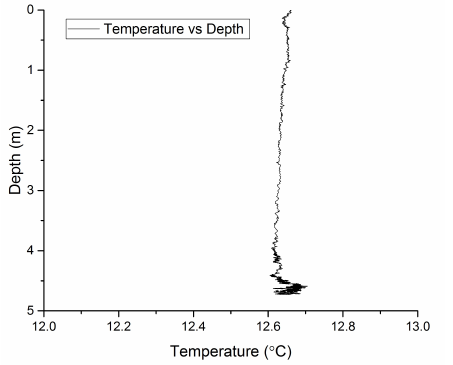
Figure 9. Depth and temperature measurement during deployment of the ROV